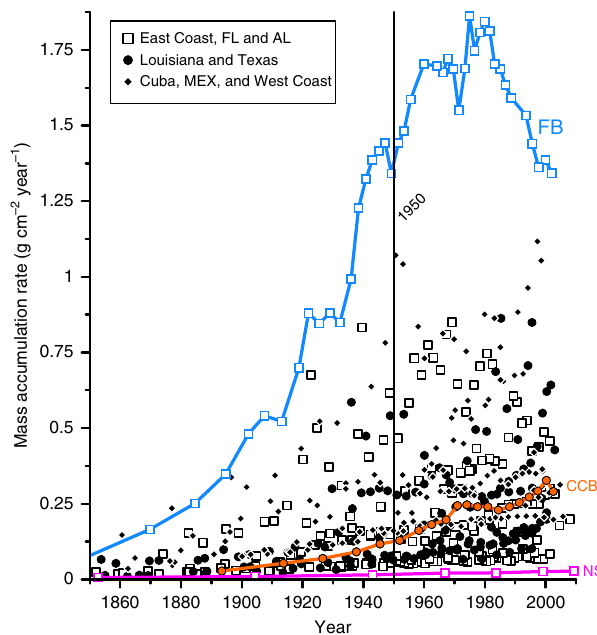
Fig. 3 Mass accumulation rates among sites and through time. Sedimentary records ( N = 25) extend >100 years, span a range of mass accumulation rates (MAR), and show an increase in sedimentation through time, as exempli fi ed by Florida Bay (FB; average MAR = 1.405 g cm − 2 yr − 1